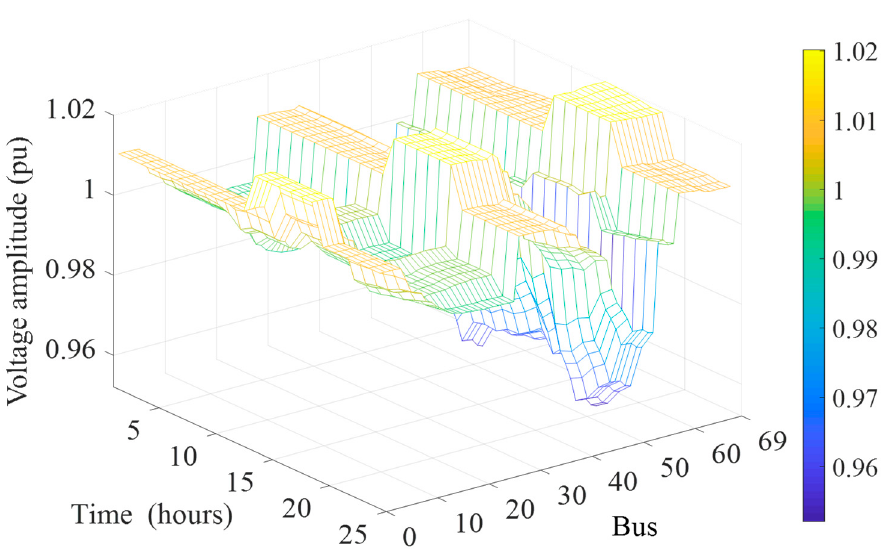
Figure 11. Bus voltage amplitude of 69-bus distribution network. Table 4. Comparison of optimization results of the two distribution networks.